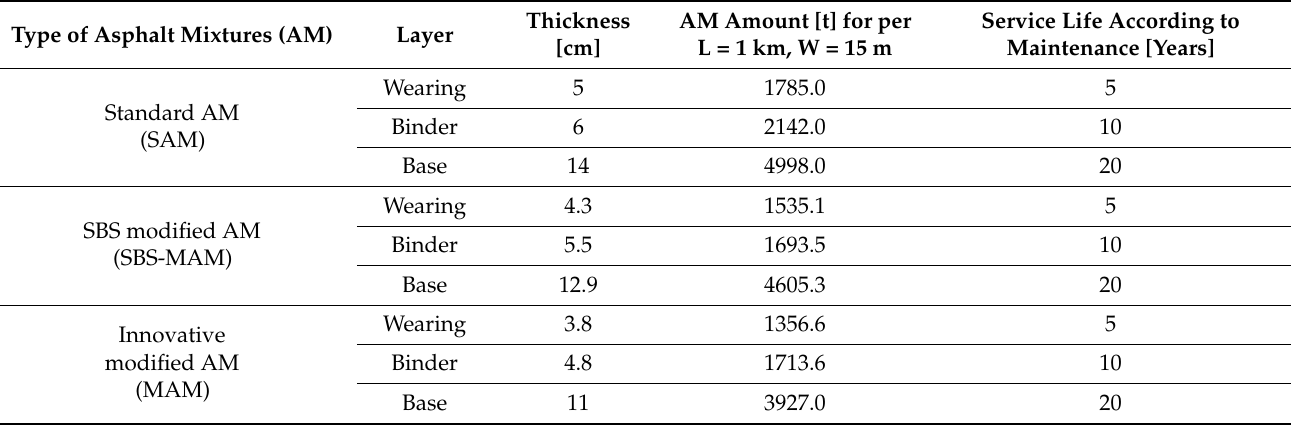
Table 3. Second case study. Characteristics and performance of different asphalt pavements with different thickness and equal AM stiffness and durability for each